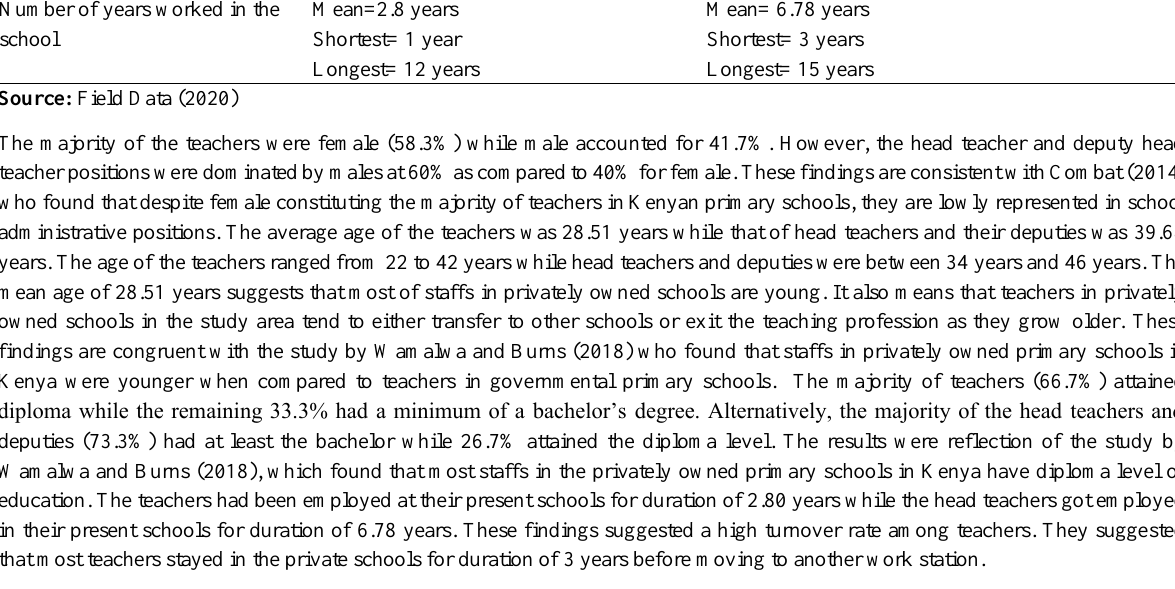
Table 4: Labour Turnover in Private Primary Schools in Rongai Sub-County